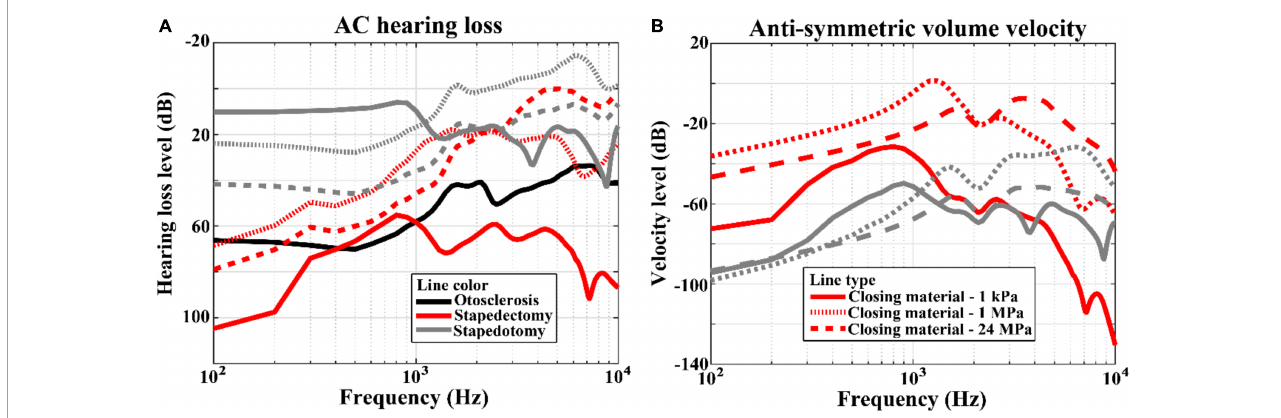
FIGURE5 (A) Hearing losses and (B) anti-symmetric volume velocities between the oval window and round window for the AC simulation results. The line styles represent variations in the Young’s moduli of the closing materials. The solid, dotted, and dashed lines correspond to 1 kPa, 1 MPa, and 24 MPa, respectively. On the other hand, the line color indicates the simulation condition; the black, red, and gray lines describe otosclerosis, stapedectomy, and stapedotomy conditions, respectively.